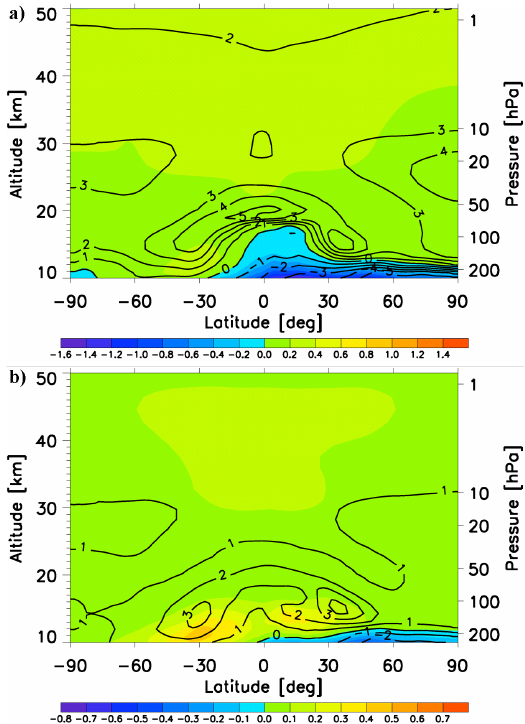
Figure 5. Annually, zonally averaged HO x concentration changes in units of 10 6 molecules 2 Fig. 5. Annually, zonally averaged HO x concentration changes in cm -3 (shown by color) and the relative change in % (shown by contours) in the H 2 -FC 3 units of 10 6 moleculescm − 3 (shown by color) and the relative scenarios compared with the BL scenarios as a function of latitude and altitude for (a) A1FI 4 change in % (shown by contours) in the H 2 -FC scenarios compared and (b) B1 scenarios. 5 with the BL scenarios as a function of latitude and altitude for (a) A1FI and (b) B1